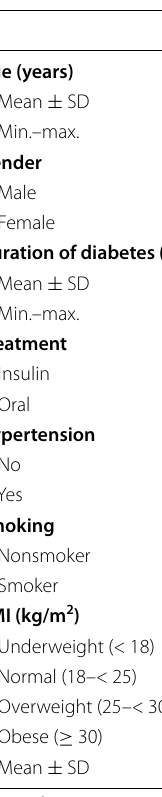
Table 1 Characteristics of the studied patients ( n